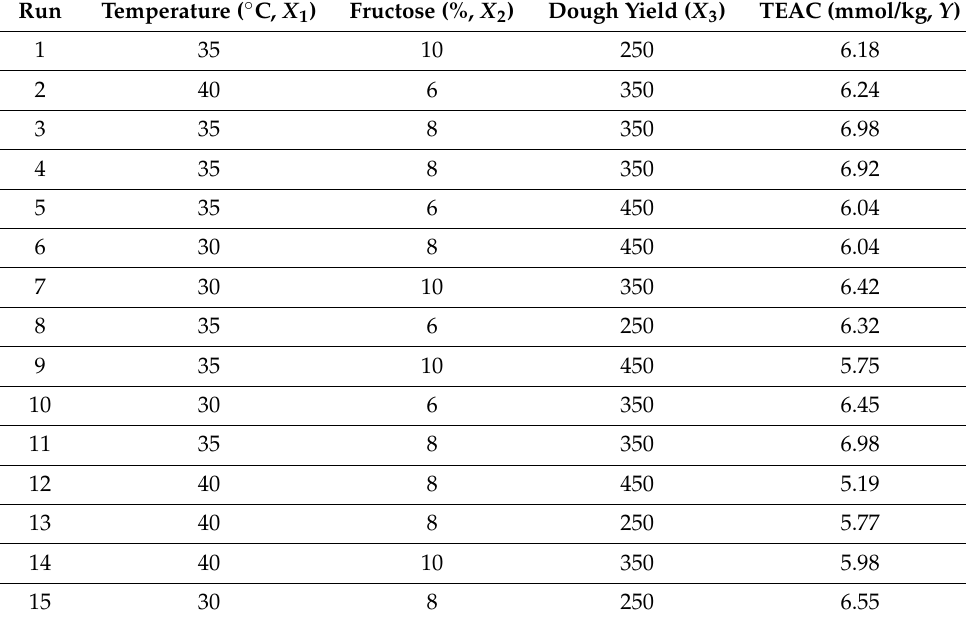
Table 1. Experimental design for RSM of the bread